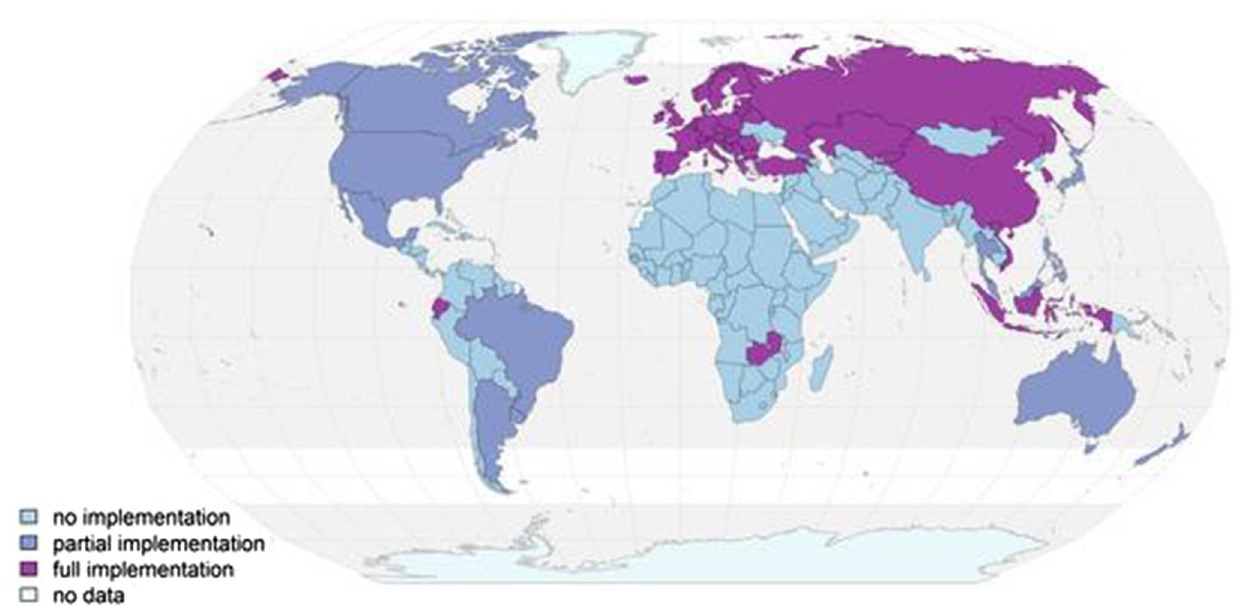
Fig. 10 Biosphere design of GHS application (Persson et al.